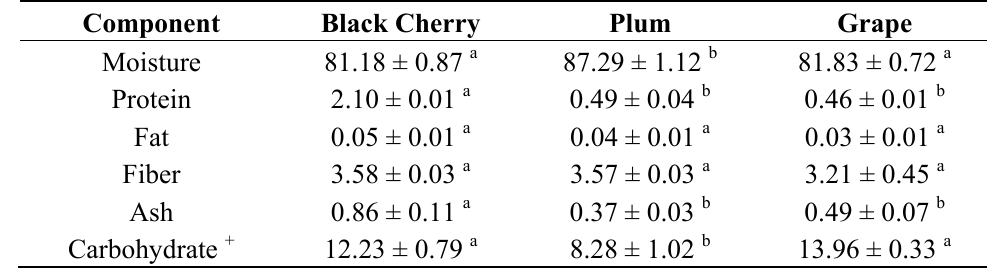
Table 1. Proximate composition of black cherry fruit, plum, and grape *